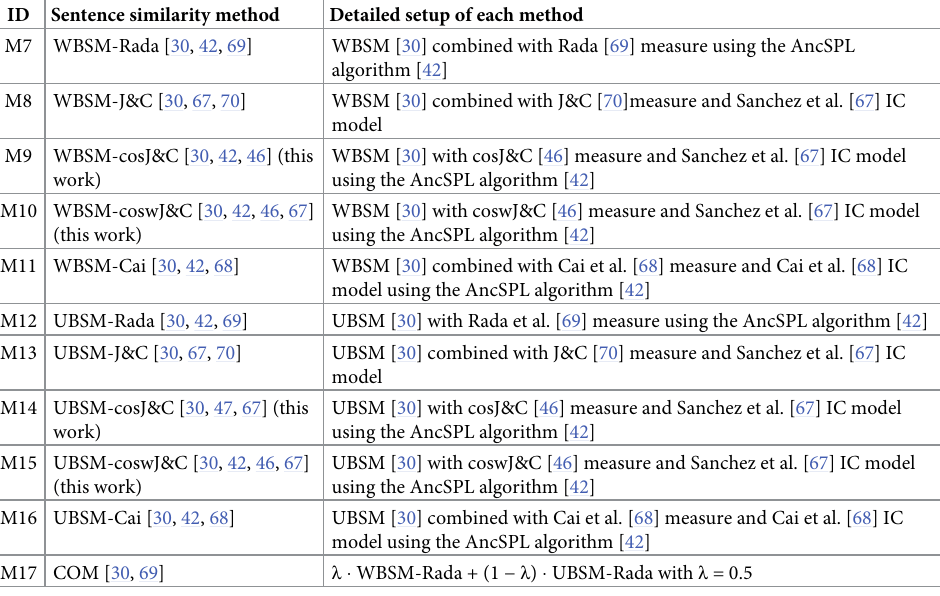
Table 3. Detailed setup for the ontology-based sentence similarity measures evaluated in this work. The evaluation of the methods using Rada [69], coswJ&C [46], and Cai [68] word similarity measures use a reformulation of the origi- nal path-based measures based on the new Ancestors-based Shortest-Path Length (AncSPL) algorithm [42].